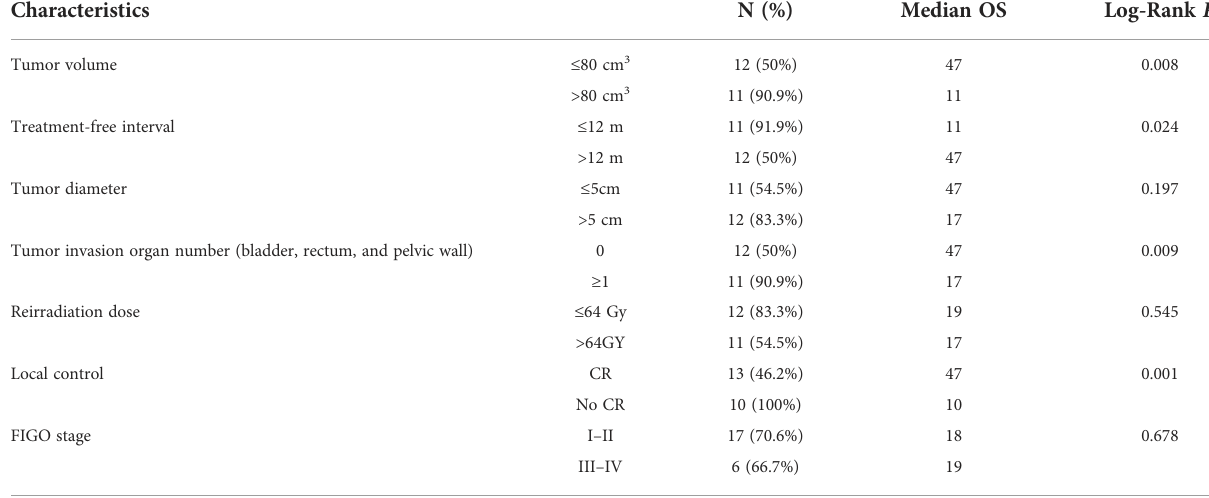
TABLE 4 Univariate analysis of survival after